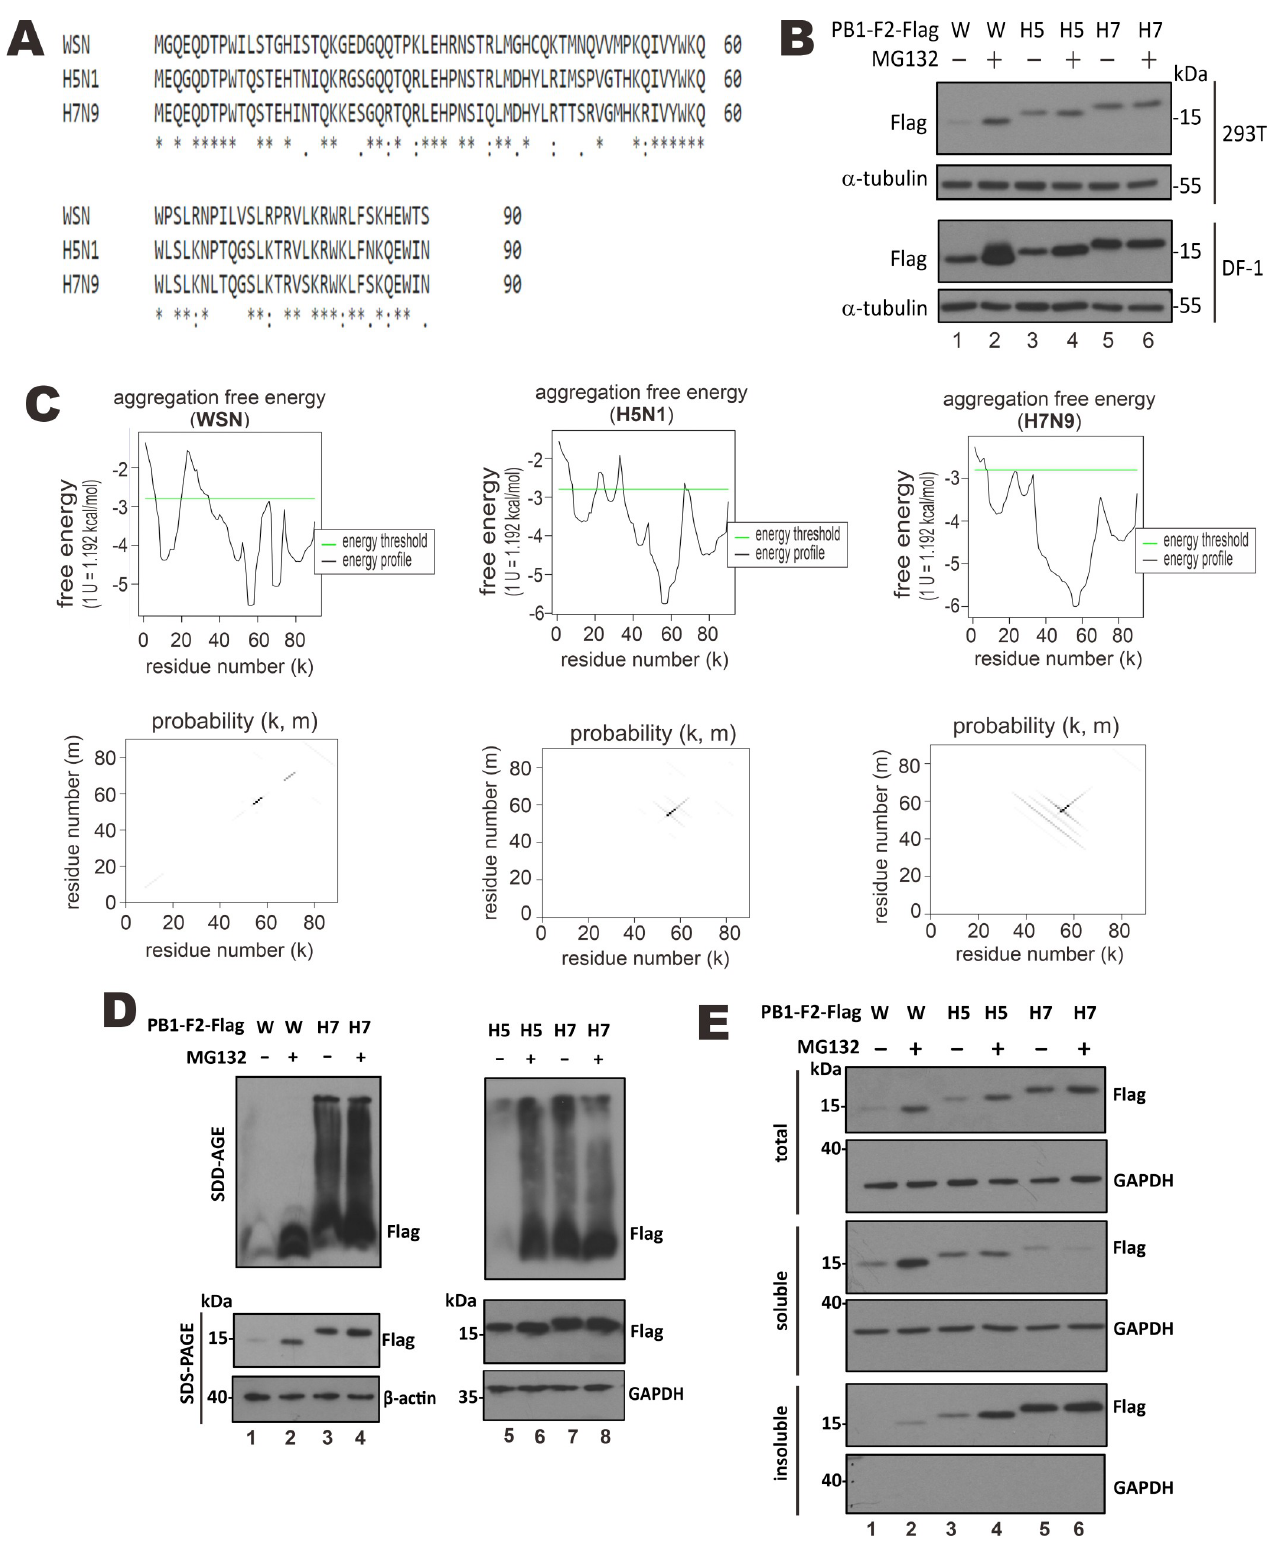
Fig 1. High aggregation potential of H7N9 PB1-F2. (A) Sequence alignment of PB1-F2 proteins from WSN, H5N1 and H7N9 viruses. Amino acid sequences of PB1-F2 proteins from human WSN, H5N1 and H7N9 viruses were aligned by the Clustal Omega program